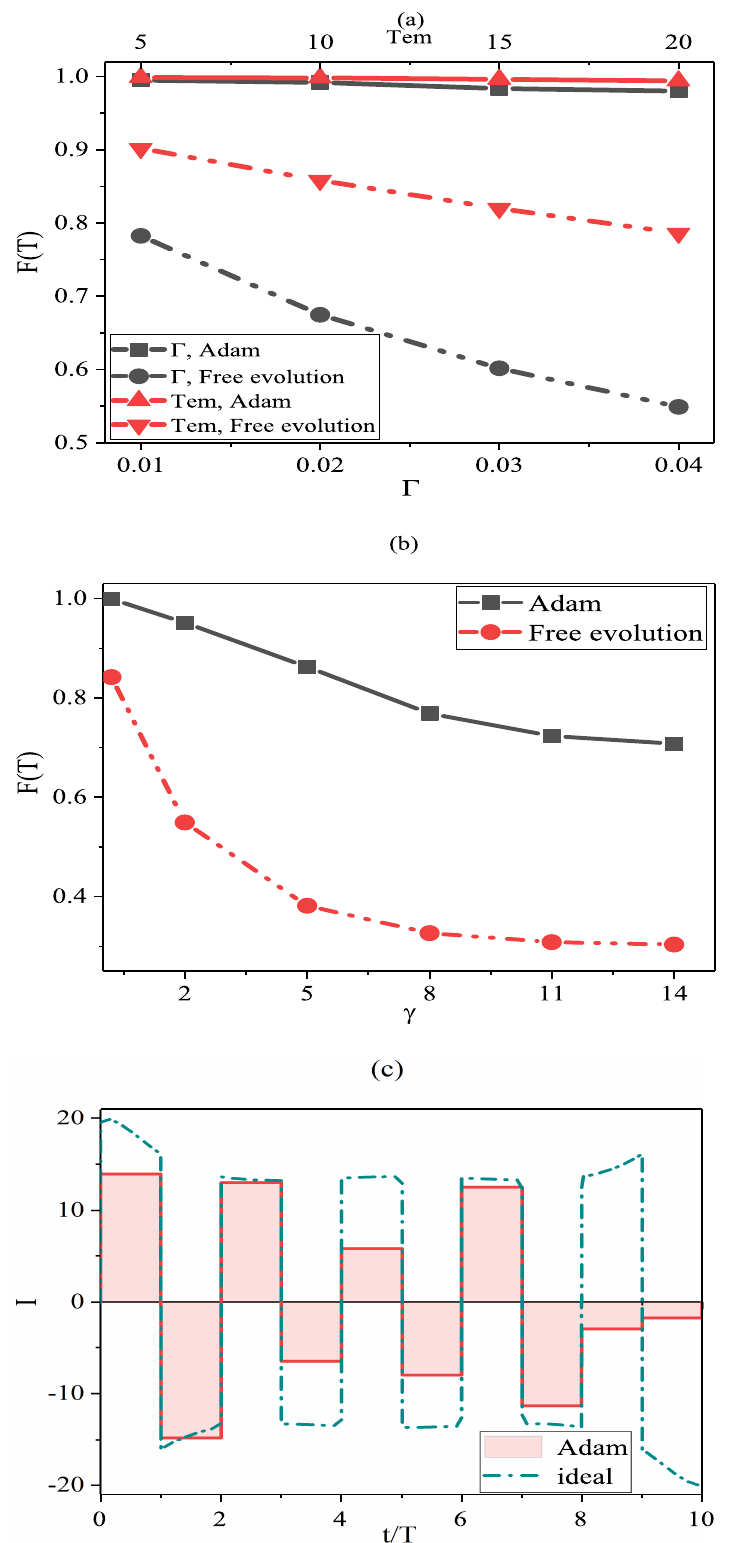
Figure 3. The fidelity F ( T ) with and without optimal pulses for different parameters. Only one environmental parameter is changed per line, the rest of the environmental parameters are the same. L = Σ i σ − . ( a ) γ = 2, Tem = 10 for Γ . Γ = 0.005, γ = 2 for Tem . ( b ) Γ = 0.04, Tem = 10 for γ . ( c ) The i profile of the ideal pulses and Adam pulses. The environmental parameters Γ = 0.04, γ = 14, and Tem =